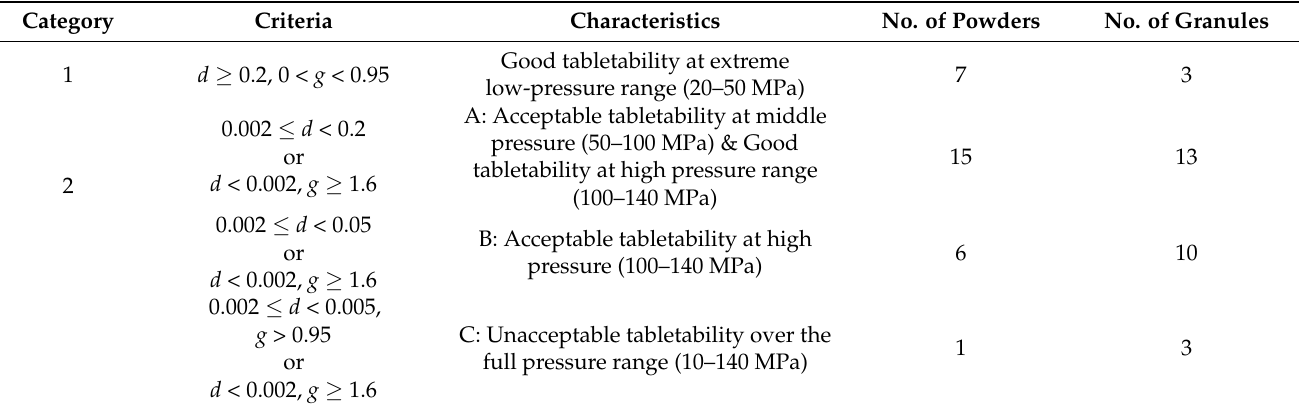
Figure 5. The tensile strength vs. compression pressure curves for 29 materials. ( a ) the powdered materials; ( b ) the granular materials. Table 3. The tabletability criteria and classification results for 29 materials.